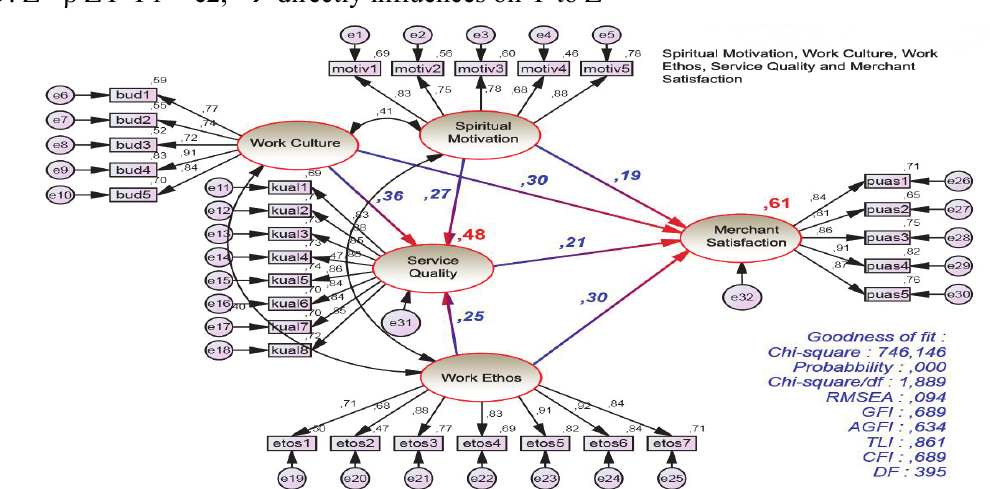
Fig. 2. Spiritual Motivation, Work Culture, Work Ethos, Service Quality and Merchant Satisfaction Model testing was performed using the regression coefficients for the variables Motivation Spiritual (X1), Work Culture (X2), Work Ethics (X3), Quality of Service (Y) and Satisfaction Traders (Z) through tables output from the sub-menu view/set as specified in Appendix 14. Based on the calculation